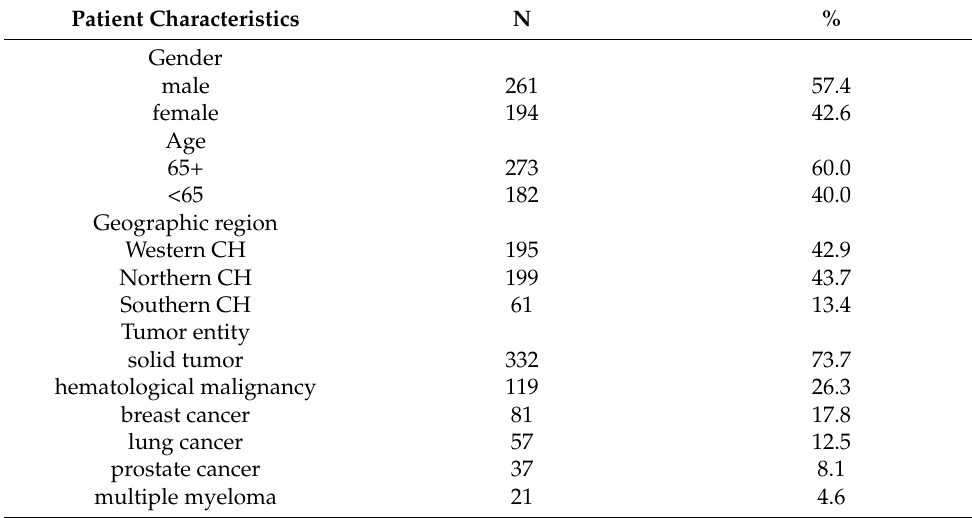
Table 1. Patient demographics and clinical